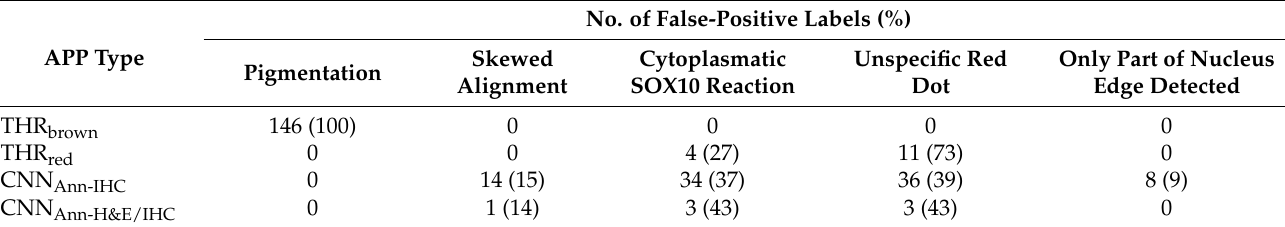
Table 3. Reasons for False-Positive Tumor-Cell Annotations in Primary Melanomas.